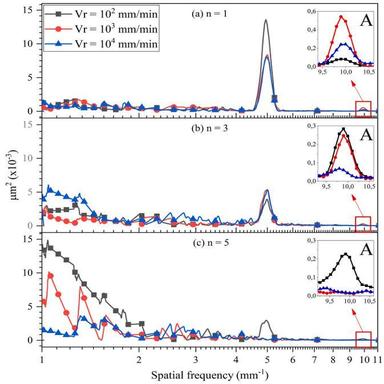
Effect of burnishing number of passes and speed on the spatial frequency: a) n = 1, b) n = 3 and c) n = 5.